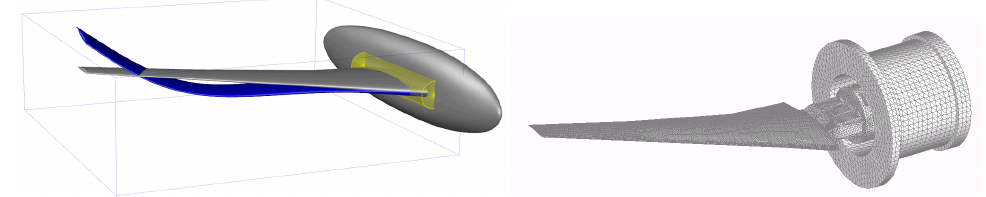
Figure 11. ( Left ): setup for the HIRENASD wing. ( Right ): FEM model of the